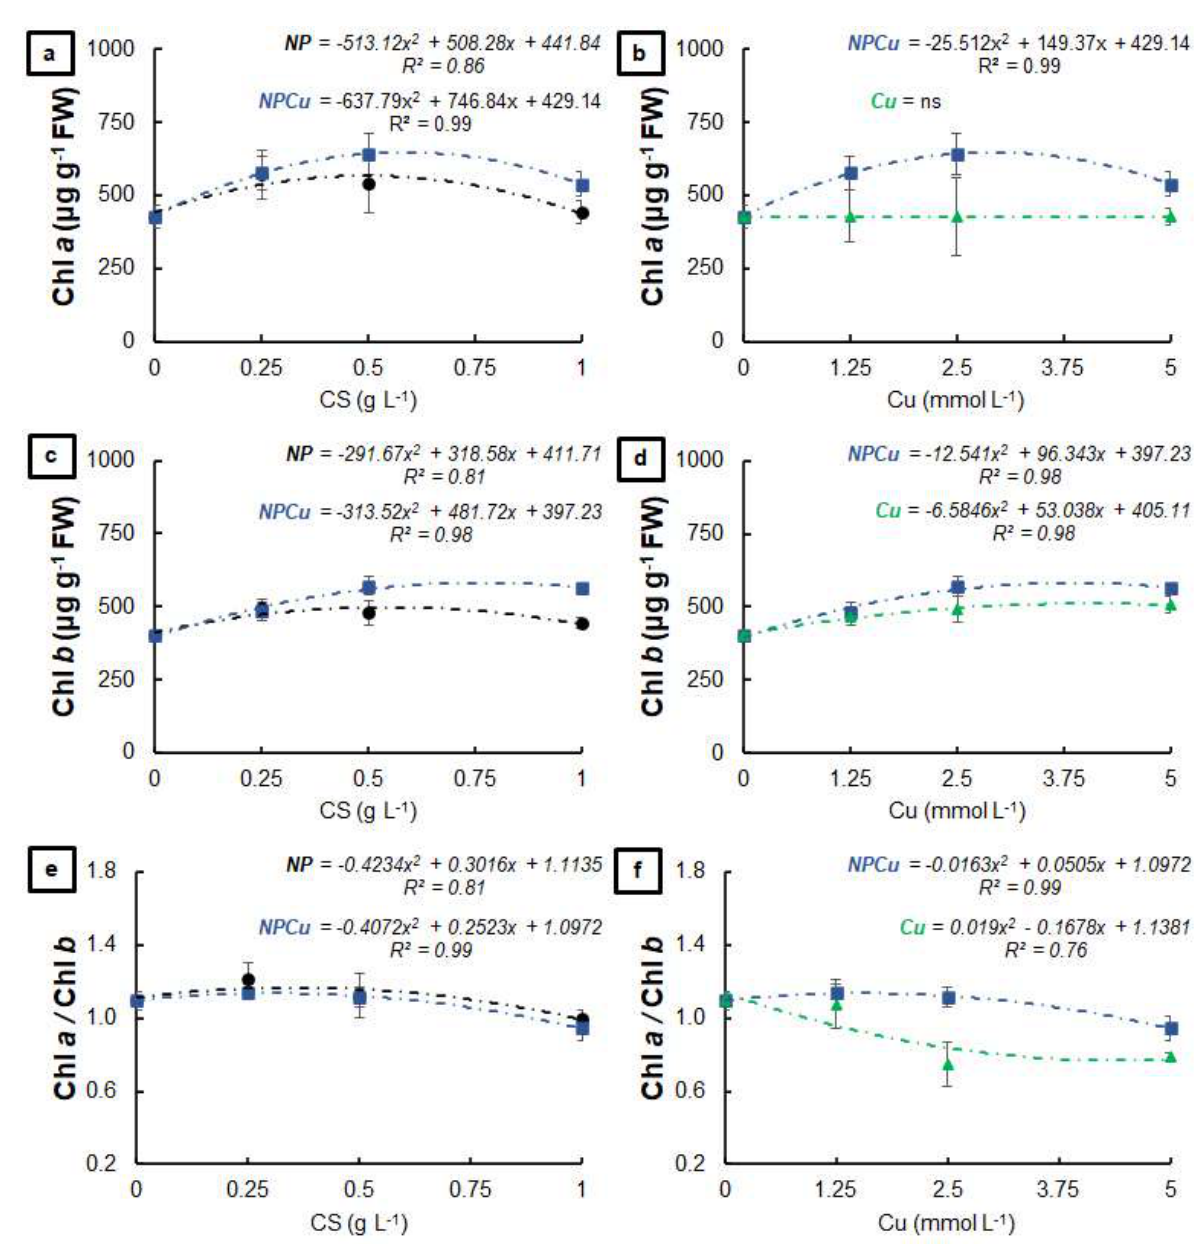
Figure 1. Chlorophyll a ( a , b ), chlorophyll b ( c , d ), and chlorophyll a /chlorophyll b ratio ( e , f ) of leaf discs of Coffea arabica cv. IPR 100 at 40 days after treatment with distilled water, as a control (CONT), chitosan nanoparticles without Cu 2+ ions (NP), chitosan nanoparticles containing Cu 2+ ions (NPCu), and free Cu 2+ ions (Cu). The formulations were diluted in distilled water, obtaining the corresponding concentrations of chitosan (CS) in NP and NPCu treatments (0.25; 0.5; 1 g L − 1 ) and of Cu 2+ ions (1.25; 2.5; 5 mmol L − 1 ) in NPCu and Cu treatments. Results are expressed as mean ( n = 4) ± standard error. The model and coefficient of determination (R 2 ) are also shown ( p < 0.05). ns = not significant.